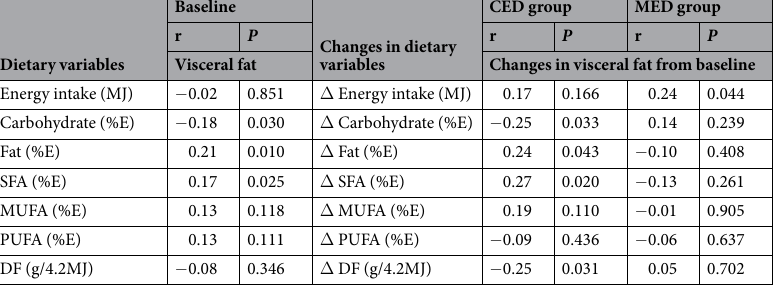
Table 7. Correlation between visceral fat and energy and macronutrient intake at baseline, and changes in visceral fat and caloric deficit, as well as changes in macronutrient intake. Abbreviations: SFAs: saturated fatty